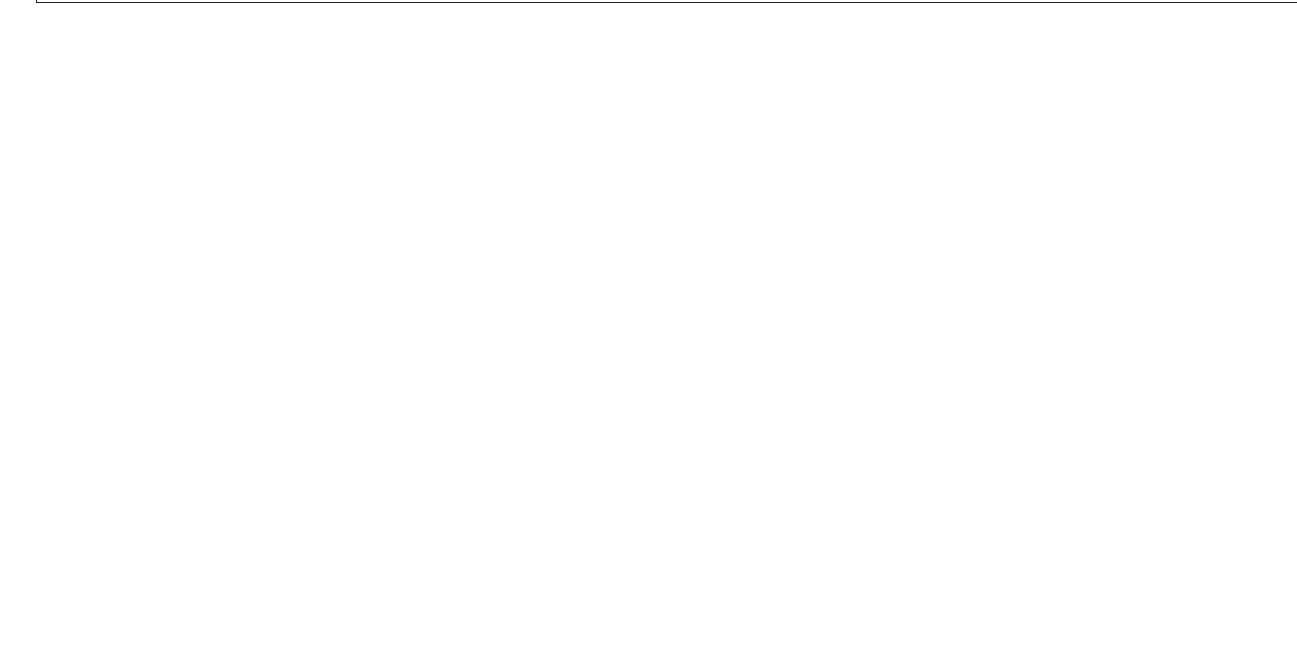
Figure A1 | Data shown in Figure 1 of rousselet and Pernet’s article. All conventions are as in Figure 1C